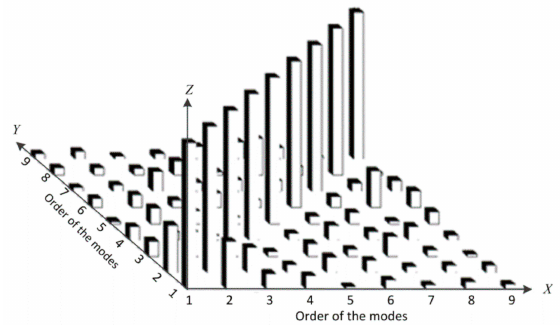
Figure 5. The correlation matrix of modals.